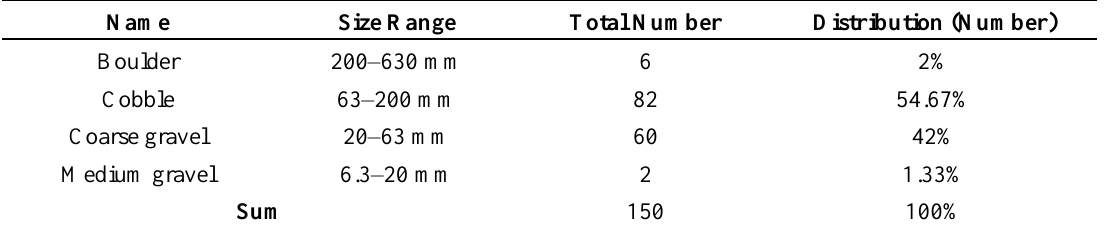
Table 2. Distribution of Field Measured Sediment Particles (ISO 14688-1 classification